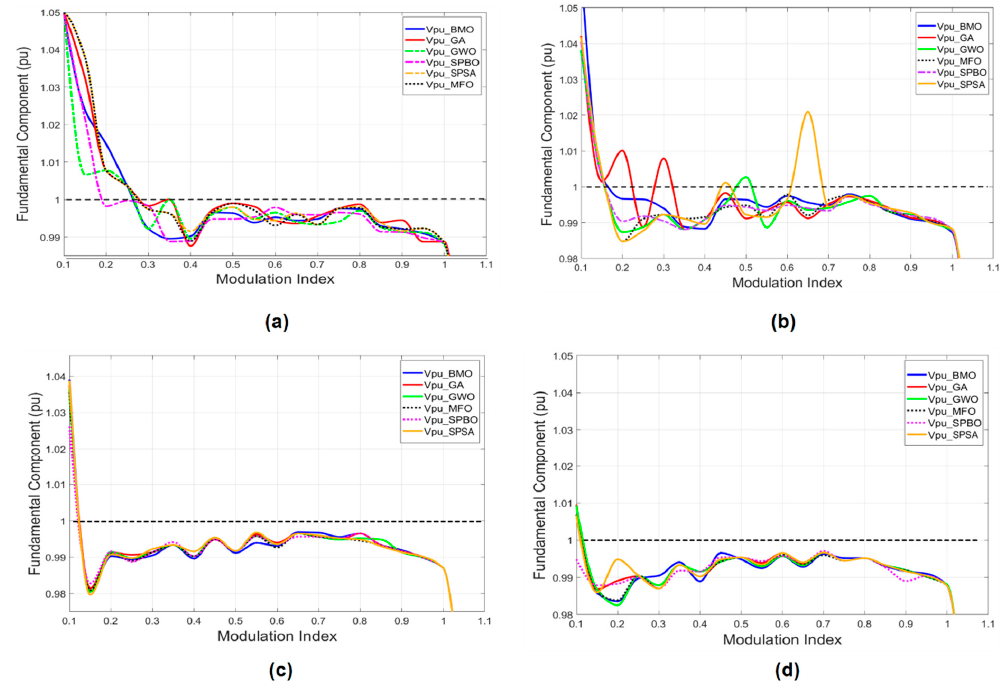
Figure 7. The output voltage (per unit) variations versus modulation indexes for MLI with ( a ) 7 − level, ( b ) 11 − level, ( c ) 15 − level, and ( d ) 19 − level applied to suggested metaheuristics.